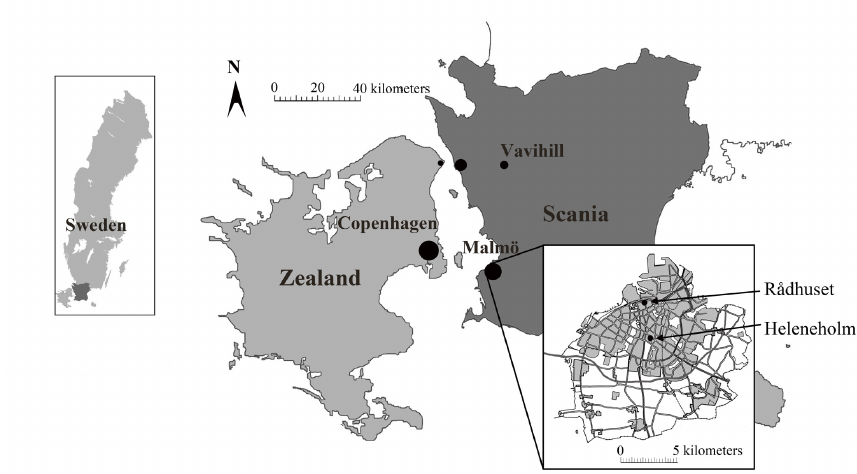
Fig. 1. Geographic map displaying the measurement station in Malm¨o (R˚adhuset), the meteorological mast (Heleneholm) and the Vavihill field station in southern